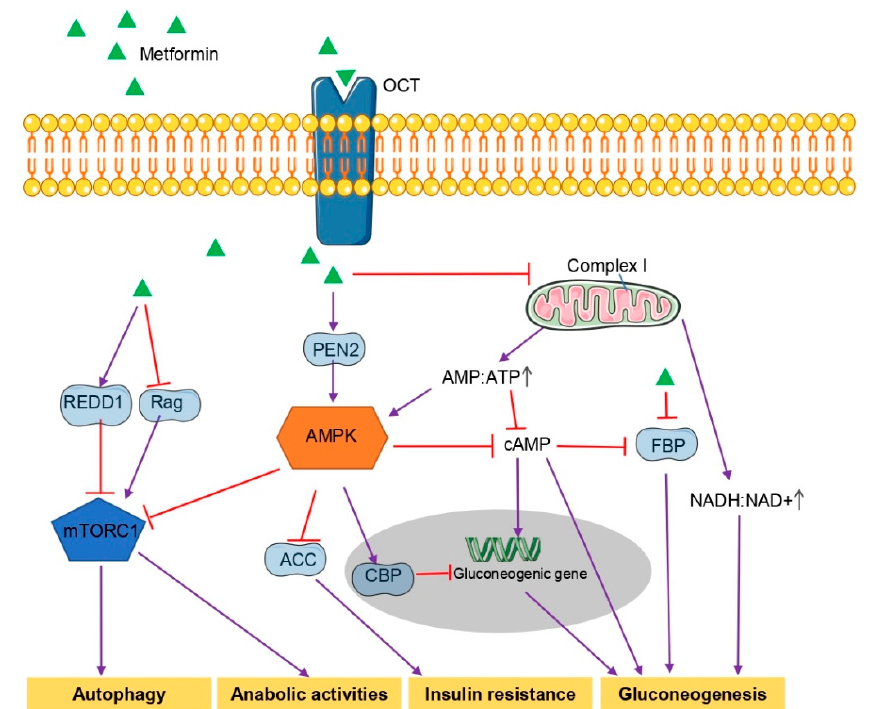
Figure 1. The general mechanism underlying the hypoglycemic effects of metformin. Metformin activates AMPK through lysosomal or mitochondrial mechanisms. AMPK increases insulin sensitivity by inhibiting ACC, activates CBP to inhibit gluconeogenesis gene expression, inhibits mTORC1 to suppress cellular anabolic activity, and inhibits cAMP production to reduce gluconeogenesis. In addition, metformin can also achieve glucose reduction in a non-AMPK-dependent manner by inhibiting AMP:ATP ratio and NADH:NAD+ ratio through mitochondrial mechanisms or by directly targeting FBP. REDD1, regulated in development and DNA damage response 1; Rag, Rag family of GTPases; PEN2, presenilin enhancer 2; AMPK, 5’-AMP-activated protein kinase; mTORC1, mechanistic target of rapamycin complex 1; ACC, acetyl CoA carboxylase; FBP, fructose-1,6-bisphosphatase; CBP, CREB binding protein; OCT, organic cation transporters; ATP, Adenosine triphosphate; AMP, adenosine monophosphate; NADH, the reduced form of nicotinamide adenine dinucleotide; NAD+, the oxidized form of nicotinamide adenine